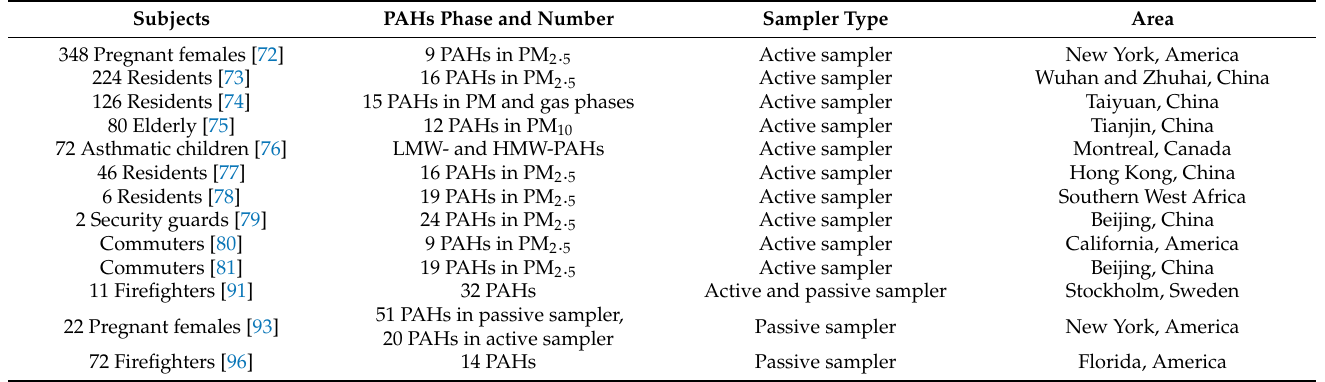
Table 2. Previous studies of PAH exposure measured by personal